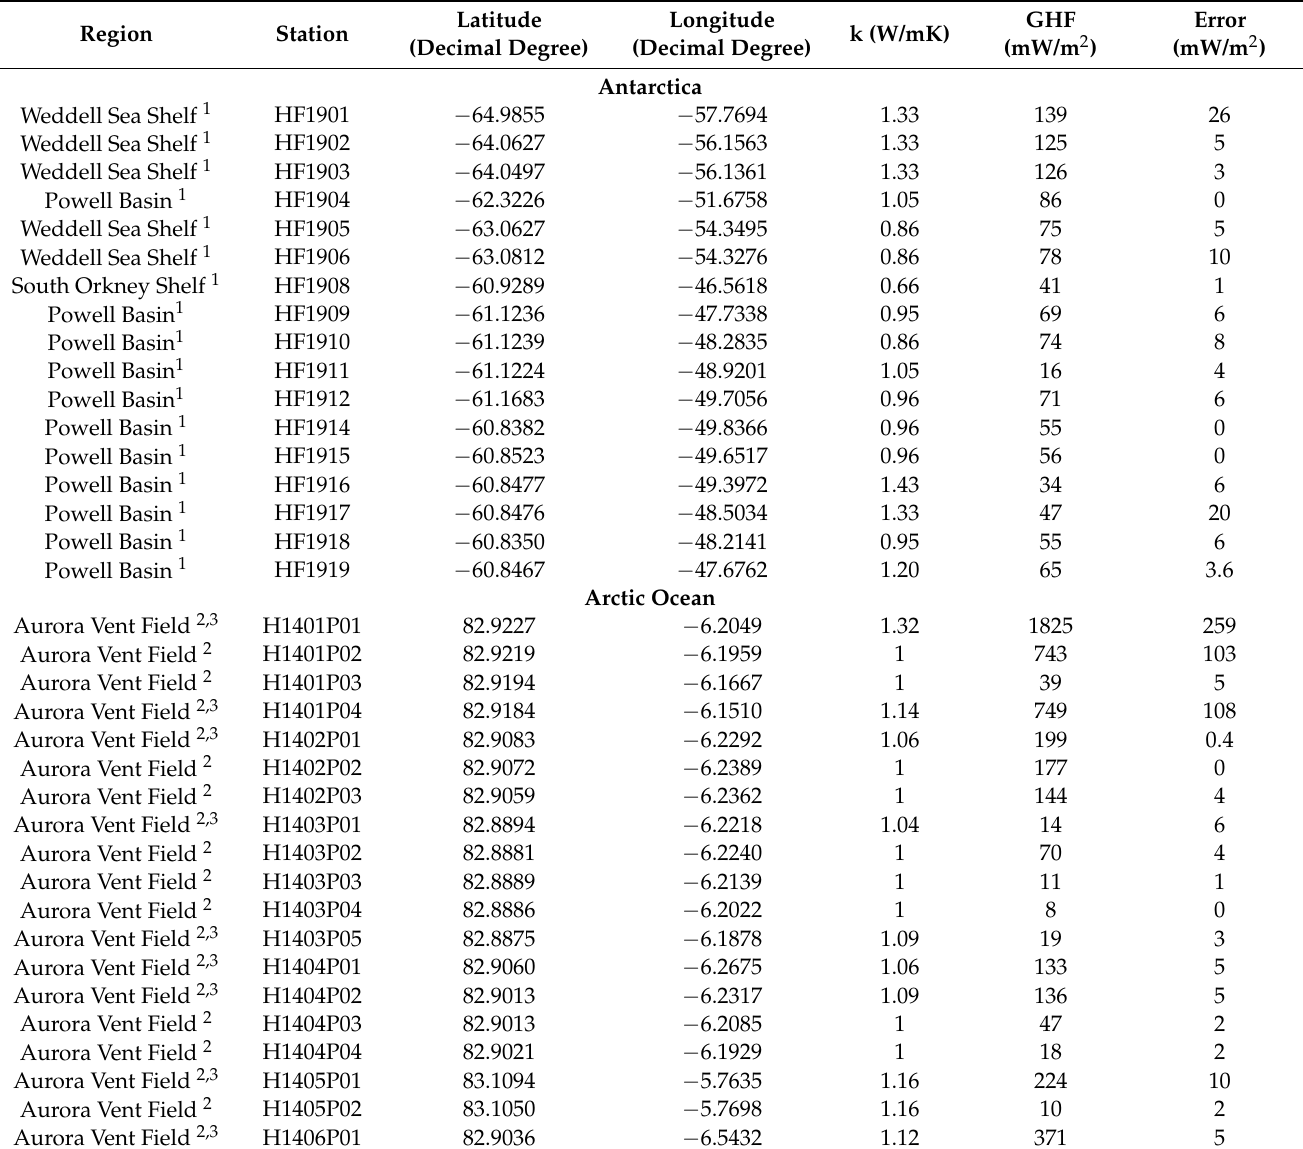
Figure 6. Temperature-depth profiles from five in situ measurements across the western Weddell Sea Shelf. Note the scale bar indi- cating a range of 1 °C. Table 1. Results of geothermal heat flow estimates from thermal measurements during RV Polarstern Expedition PS118 and PS86 (supplementary materials). Latitude and longitude are given in decimal degrees, thermal conductivity (k) for each station, the result- ing geothermal heat flow (GHF). The GHF error estimate is based on minimum and maximum geothermal gradients and considera- tions of k for each station.